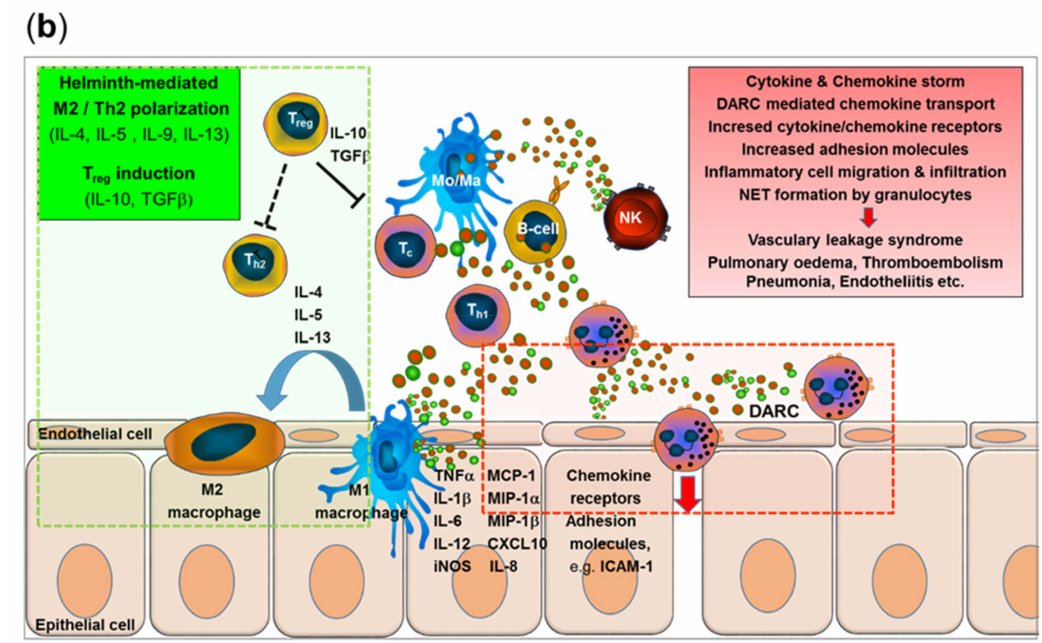
Figure 5. ( a ). SARS-CoV-2 binds to the ACE-2 receptor, followed by spike protein cleavage, membrane fusion, and endocytosis. RNA of single-stranded RNA viruses activates the Toll-like receptors TLR7 and TLR8. Double-stranded RNA intermediates are recognized by TLR3. TLR activation triggers transcription of the interferon-regulator factor (IRF) family, but also the activation of IKK (I κ B kinases), phosphorylation, ubiquitination, and proteasomal degradation of the cytoplasmic inhibitor factor I κ B α , and release of the NF- κ B (p50/p65) to enter the nucleus. The final sequence of NF- κ B activation is shared with multiple cytokine receptor- and TLR-mediated signal cascades, e.g., binding of TNF α or IL-1 to their receptors or binding of LPS to TLR4. Additionally, SARS-CoV-2 leads to TLR4-mediated and ER stress-induced NF- κ B activation. NF- κ B activation triggers gene expression for multiple pro-inflammatory cytokines and chemokines (with a typical M1/Th1 polarization pattern), adhesion molecules, and acute phase proteins. Released cytokines feed into accelerating feedback loops. In contrast, interferon-response factor (IRF)-related responses are largely independent of NF- κ B translocation ( a , red transparent area). Metabolic disorders, e.g., obesity and diabetes, lead to chronic NF- κ B pre-activation via hyperglycemia-induced IKK β overexpression, Protein kinase C (PKC) activation, and advanced glycosylation end products (AGEs) that bind to receptors for advanced glycosylation end products (RAGE) on vascular smooth muscle cells, leading to oxidant stress. NF- κ B triggered cytokine (TNF α , IL-1 β ) expression feeds into accelerating feedback loops via TNF α /IL-1 β receptor-triggered NF- κ B activation and increased expression of RAGE ( a , blue transparent area). Aging-related genotoxicity, inflammation, ER stress, and oxidative stress stimulate the NF- κ B pathway. An “inflamm- aging”-associated dysregulation of cytokine homeostasis feeds into auto amplifying loops, enhancing the COVID-19- triggered acute NF- κ B activation storm ( a , yellow transparent area). The anti-helminth drug ivermectin and the anti-malaria drug artemisinin inhibit the NF- κ B pathway at various steps, with artemisinin (a proteasome inhibitor) blocking the degradation of I κ B α and the nuclear translocation of NF- κ B. ( b ). Helminth infection induces M2/Th2 predisposition, Treg, and immunosuppressive cytokines IL-10 and TGF β ( b , green transparent area), which can counteract SARS-CoV-2- triggered NF- κ B-mediated M1/Th1 polarization ( a , b , green inserts). Duffy receptor-mediated transport and transcytosis of chemokines can enhance the migration, adhesion, and extravasation of macrophages and neutrophils even at sites distant to the initially SARS-CoV-2-infected cells ( b , red transparent area), leading to the activation and damage of endothelial cells, vascular leakage, pulmonary edema, thromboembolism, and multiorgan endotheliitis ( b , red insert). This effect may be reduced in geographical areas with prevalent DARC negativity. ( a ) represents a modification of Figure 1 previously published in https://pubmed.ncbi.nlm.nih.gov/33362782/ accessed on 8 September